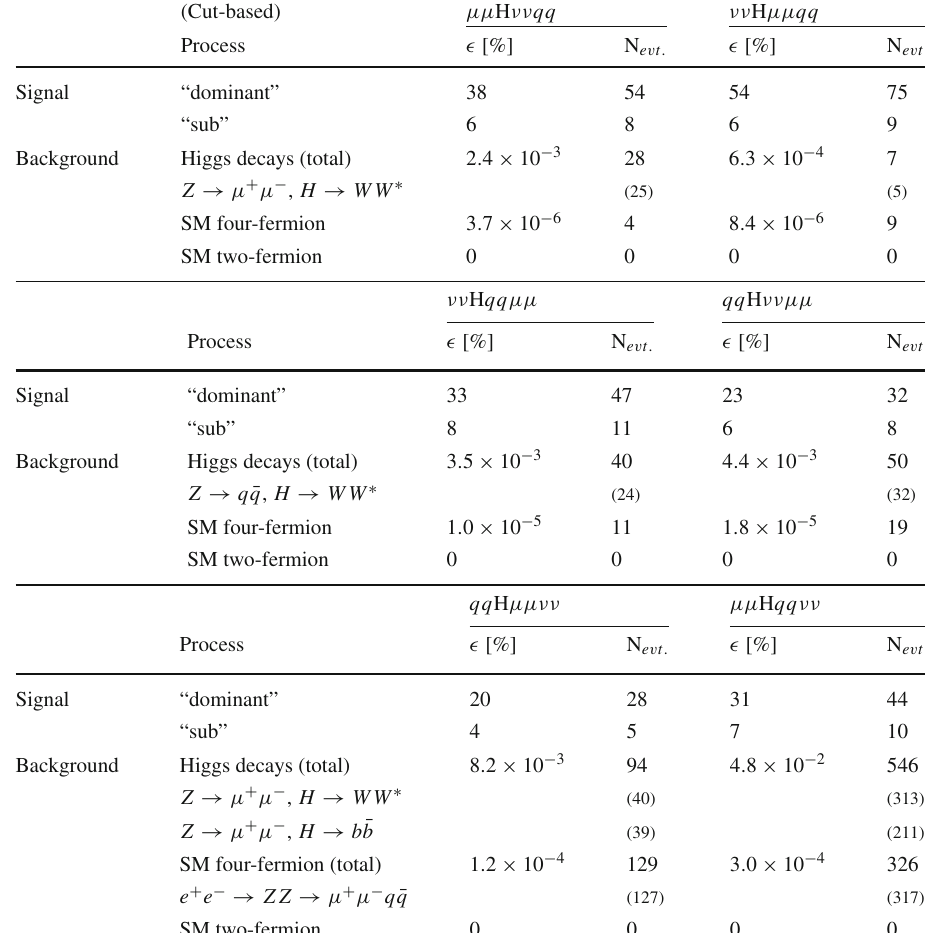
Table 2 Summary of the selection efficiency (cid:9) and the number of expected events N e v t . for each category after the final event selection in the cut-based analysis. The numbers in parentheses refer to the number of events for dominant background processes in the